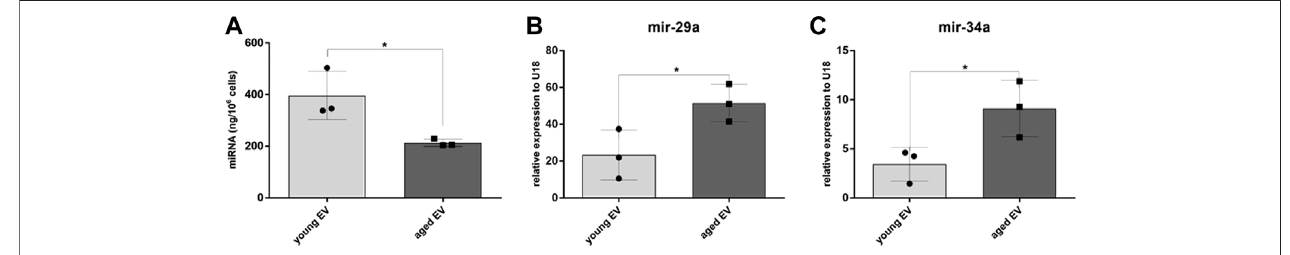
FIGURE 2 | Analysis of miRNA extracted from young and aged MSC-EVs. (A) The miRNA amount released per young and aged MSC-EVs was determined by Qubit fl uorometry. (B,C) Expressionofmir-29aandmir-34ainyoungandagedMSC-EVswasevaluatedbyquantitativereal-timePCR.Datasampleswerenormalizedto U18, the bars represent the mean ± SEM from three different MSC donors in each group (n = 3), * p < 0.05.